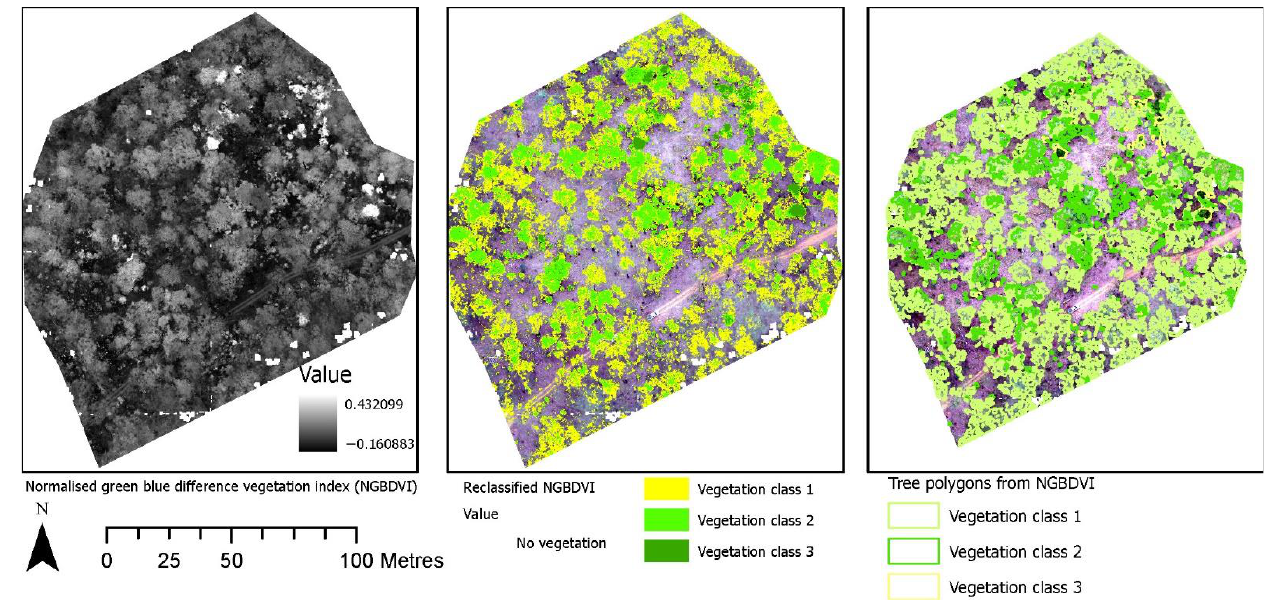
Figure 6. Identification of an index and its reclassification to extract trees and their differentiation into three potential classes, that may represent different tree species.